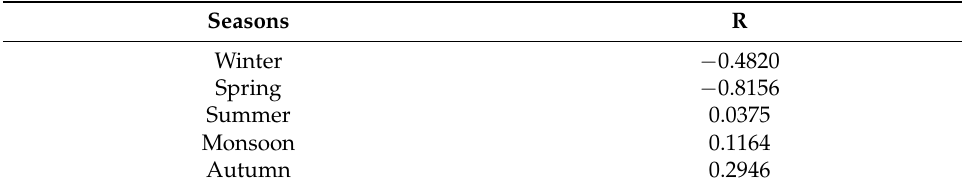
Figure 4. Declining of soil moisture from MEF to SP to Pa. Table 4. Correlation value of temperature with moisture.